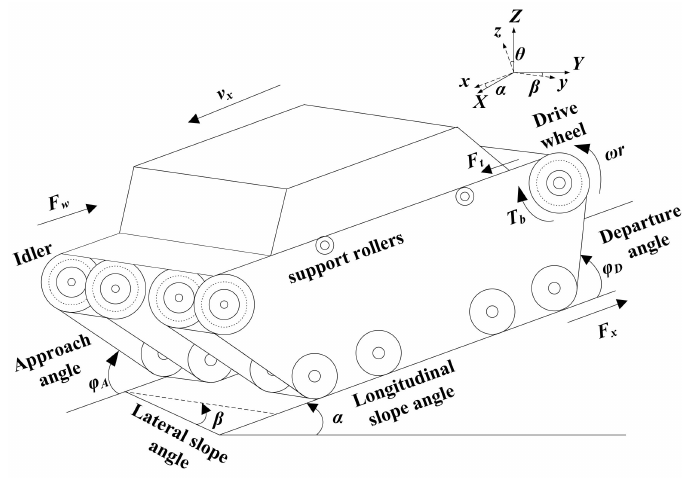
Figure 6. The force of the tracked vehicle under braking conditions.